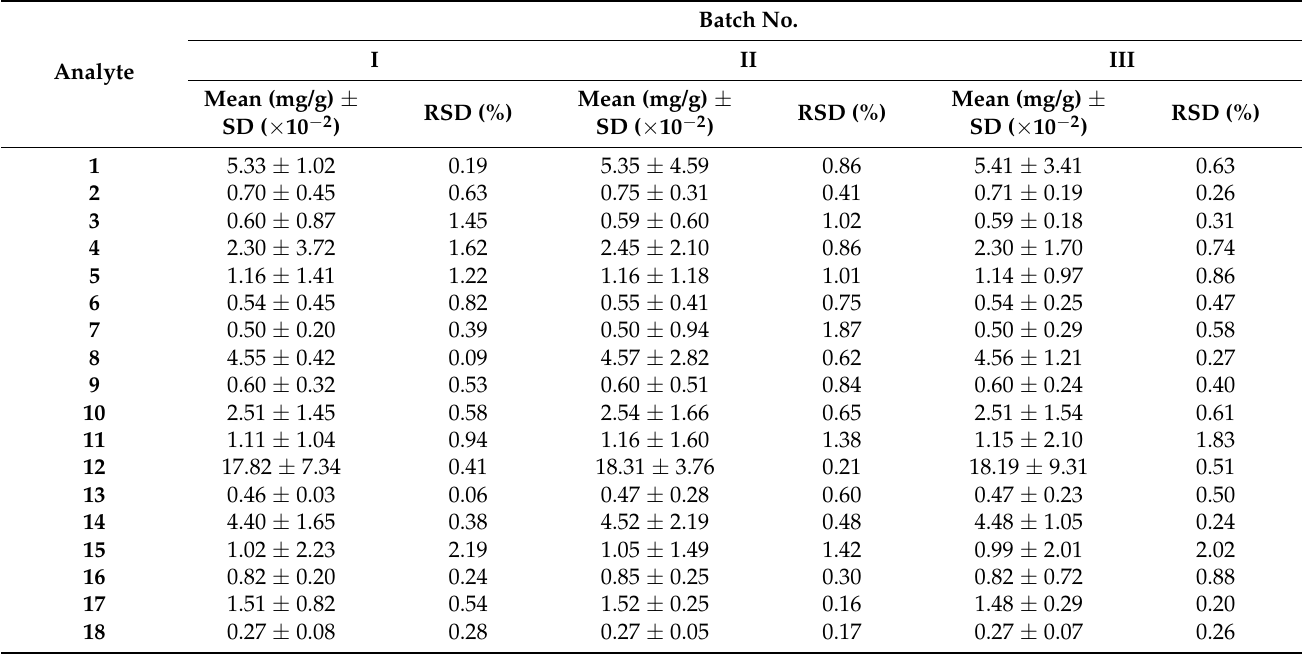
Table 4. Concentration of compounds 1 – 18 in CSBPT according to sample batches ( n = 3).